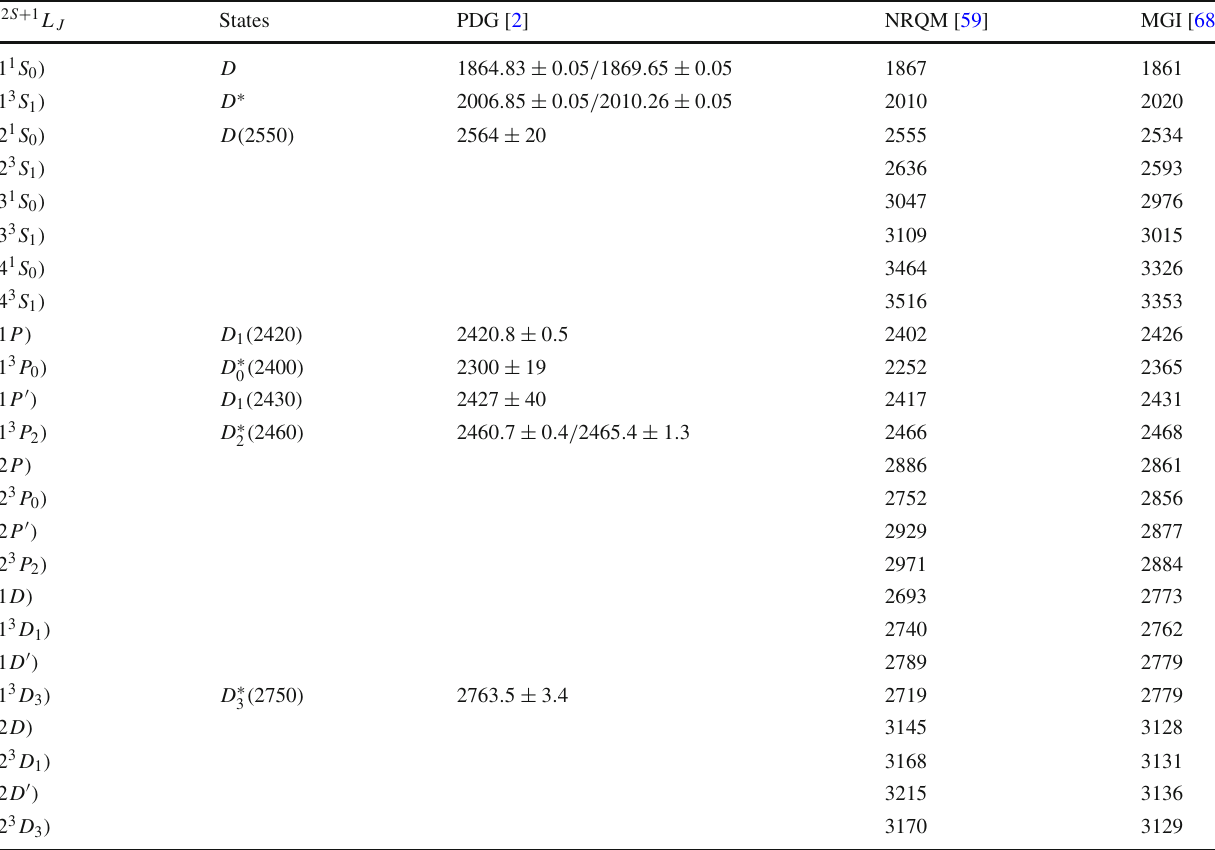
Table 2 The mass spectra (in MeV) of charm mesons obtained within the non-relativistic quark model (NRQM) and the modified Godfrey–Isgur Model